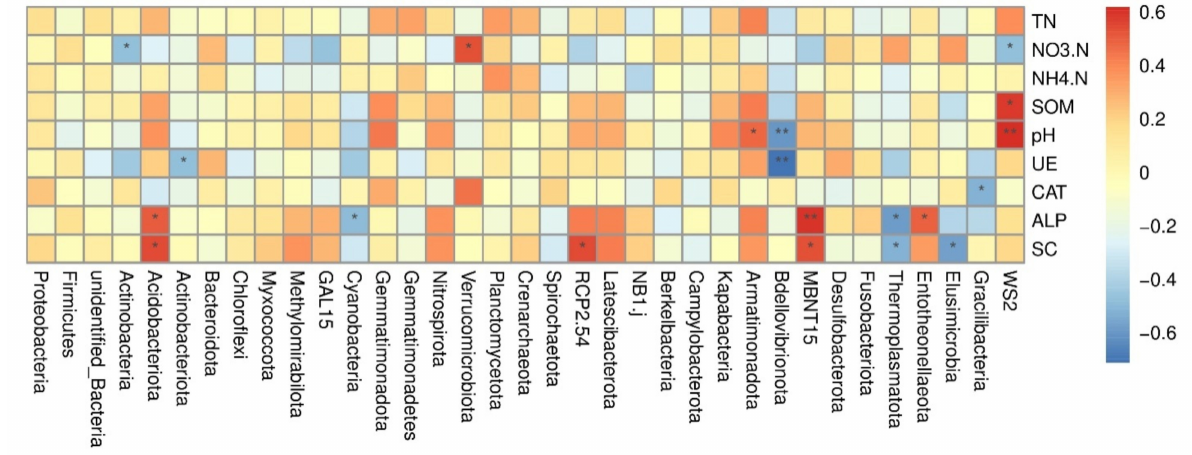
Figure 6. Spearmen heatmap correlation analysis of major bacterial phyla and environmental factors. The red mark indicates positive correlation, while the blue mark indicates negative correlation. The star marks indicate the significant